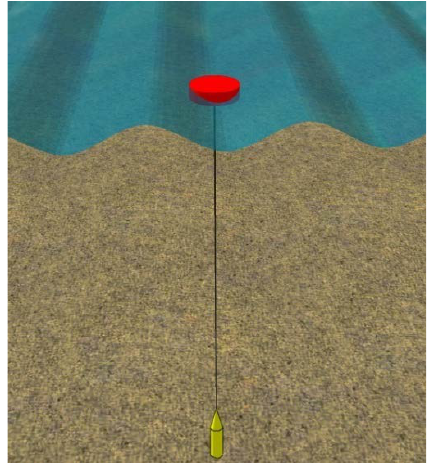
Figure 1. Sketch of the Seabased wave energy